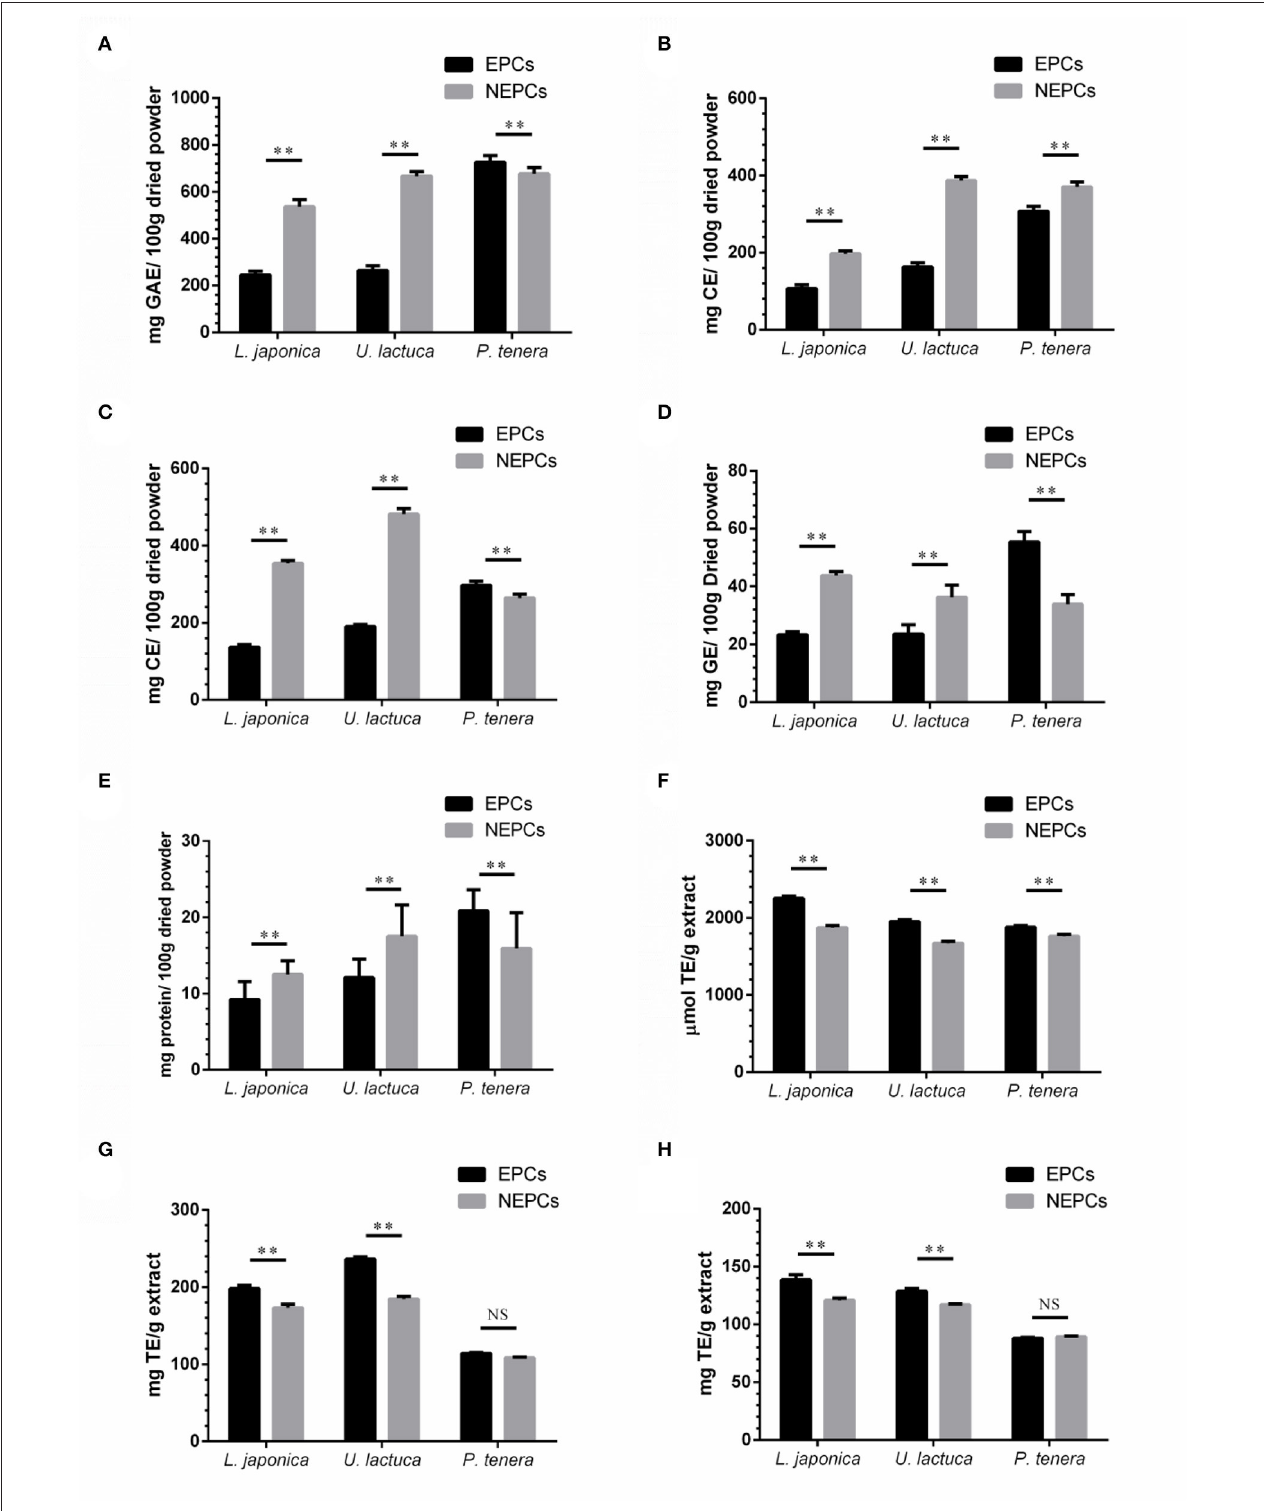
FIGURE 1 | Total phenolic contents (PCs) (A) , flavonoid contents (FCs) (B) , tannin contents (TCs) (C) , carbohydrate content (CCs) (D) , and protein contents (PRCs) (E) in EPCs and NEPCs from three edible seaweeds. The levels of ORAC (F) , DPPH (G) , and ABTS (H) of the EPCs and NEPCs from three edible seaweeds. Data were presented as mean ± SD ( n = 6). NS indicate no statistical difference, ** p < 0.01 indicate a statistical difference.